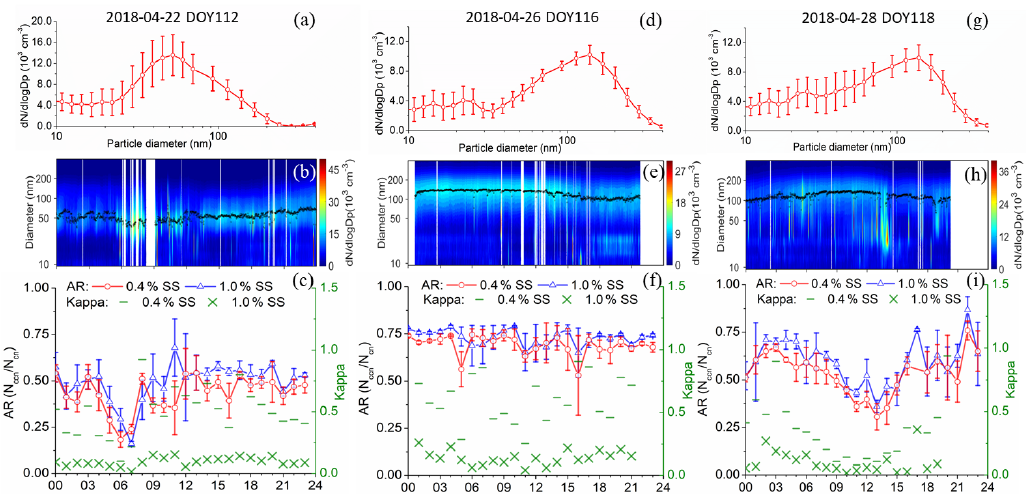
Figure 5. (a, d, g) Daily average and (b, e, h) contour plot of particle number size distributions and (c, f, i) time series of hourly averaged AR at SS of 0.4% and 1.0% and Kappa value on DOY 112, DOY 116 and DOY 118. The bars represent the standard deviation, with the mean indicated by the hollow